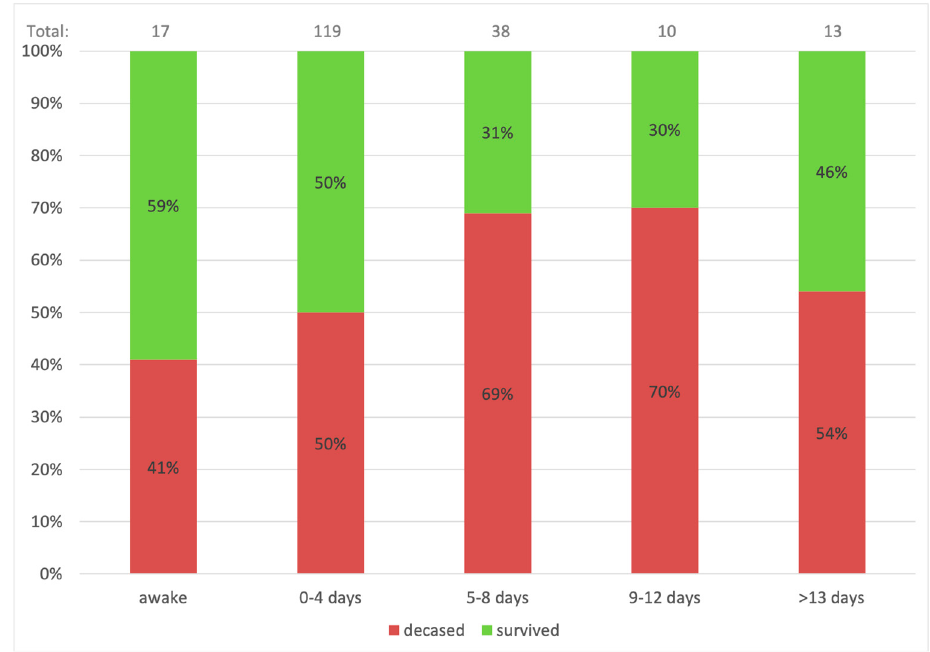
Figure 2. Pre -procedural ventilation days-related mortality . Figure 2 demonstrates the mortality and survival rate according to the duration of ventilation prior to connection to